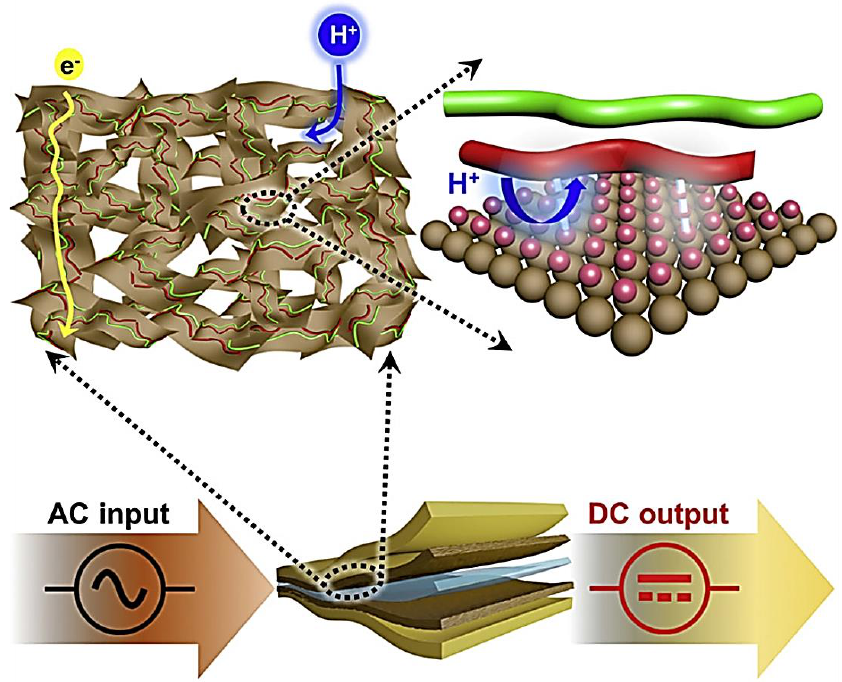
Figure 16. Energy storage devices (asymmetric supercapacitors) based on MXene/(PEDOT: PSS) nanocomposites for high ‐ frequency application (Reprinted with permission from Reference [186] Copyright 2019 Elsevier B.V.).